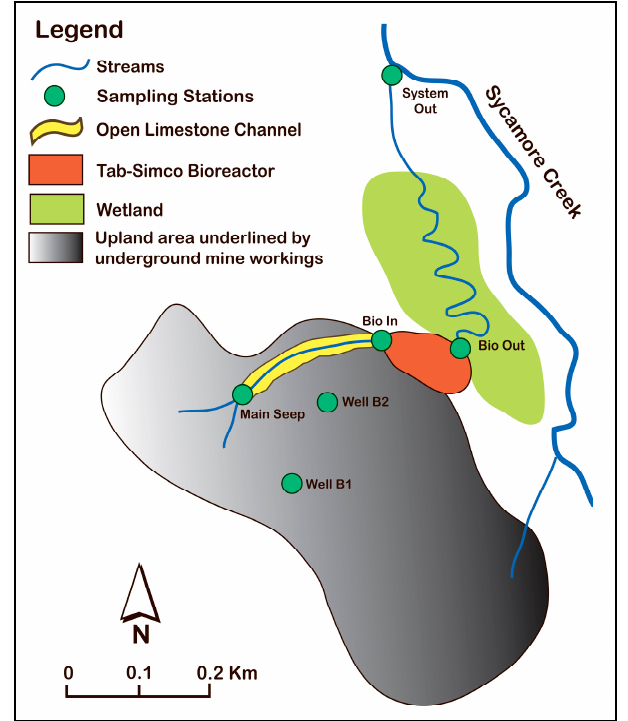
Figure 1. Plan view of the Tab-Simco site with sample locations indicated: the Main Seep